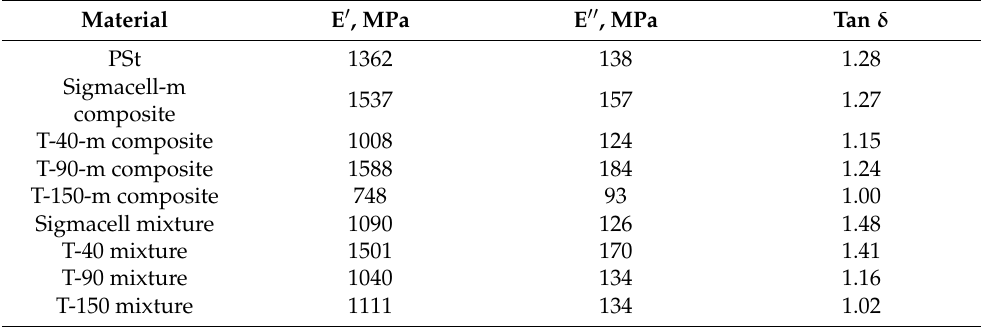
Table 6. Storage modulus (E (cid:48) ) at 25°C, loss modulus (E (cid:48)(cid:48) ) and Tan δ for composites and physical mixtures at 1 w% cellu-mer